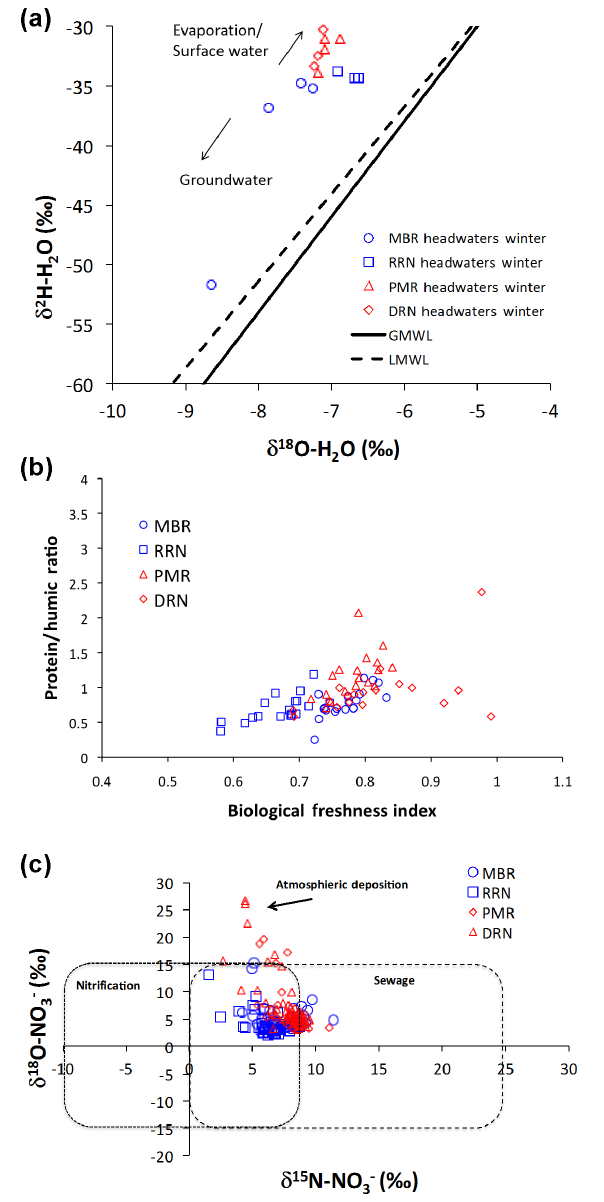
Figure 3. Comparison of (a) water isotopes ( δ 2 H-H 2 O vs. δ 18 O- H 2 O), (b) C quality metrics (biological freshness index vs. protein- to-humic ratio), and (c) nitrate isotopes ( δ 15 N-NO − ) . GMWL indicates global meteoric water line, LMWL indi- NO − 3